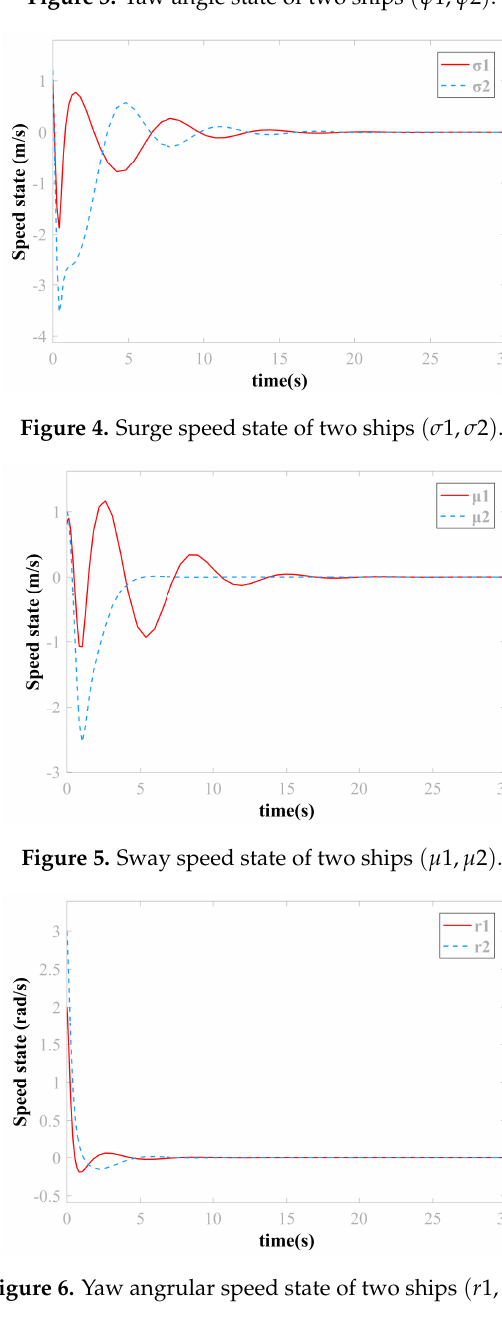
Figure 3. Yaw angle state of two ships ( ψ 1, ψ 2 ) .